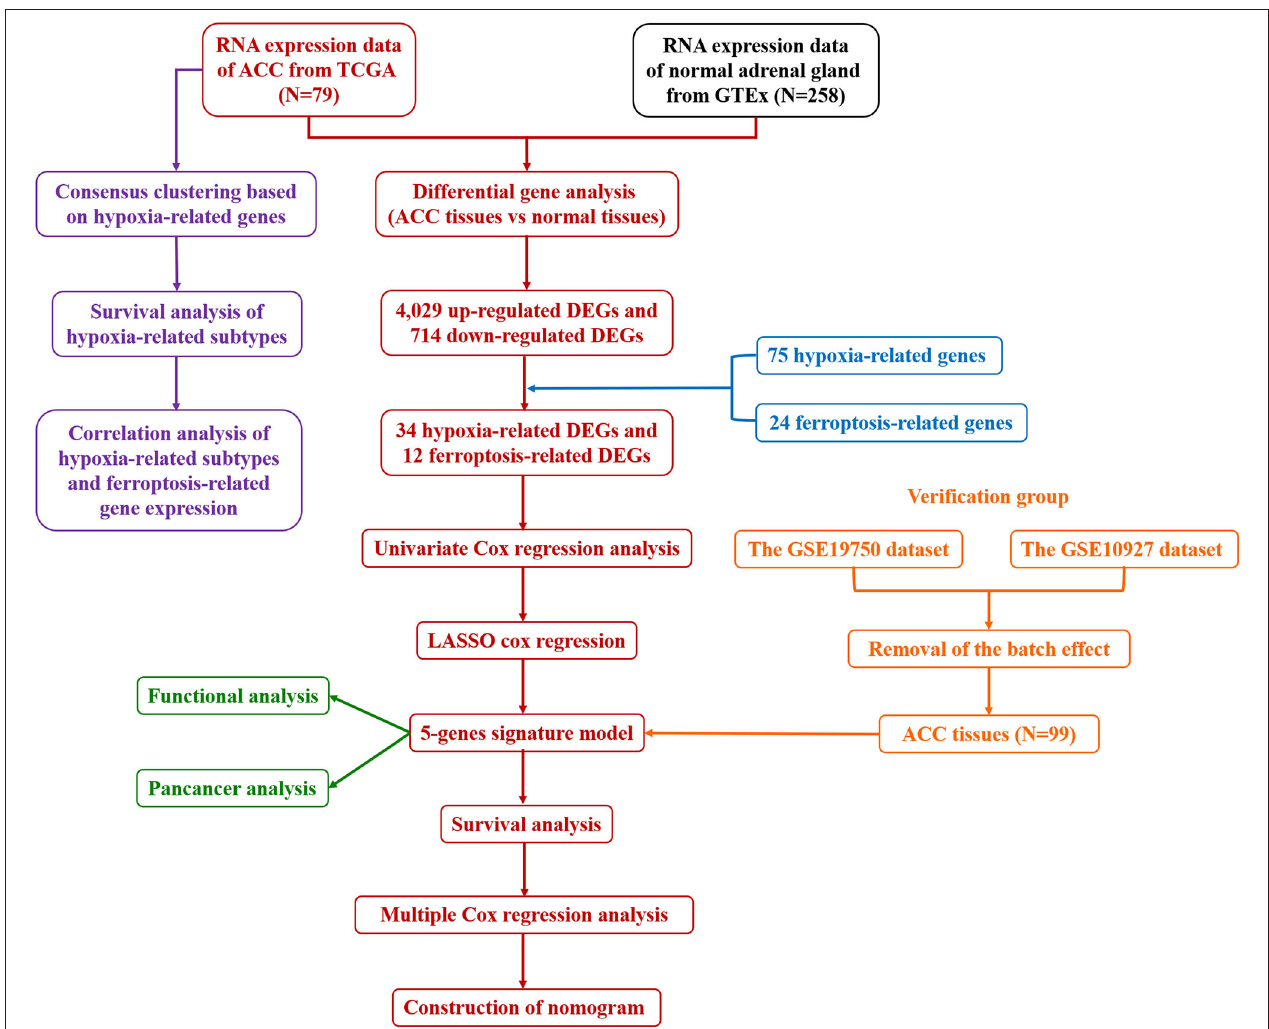
FIGURE 1 | The detailed flow chart of this study. ACC, adrenocortical carcinoma; TCGA, The Cancer Genome Atlas; GTEx, Genotype-Tissue Expression; DEGs, differentially expressed genes; LASSO, least absolute shrinkage and selection